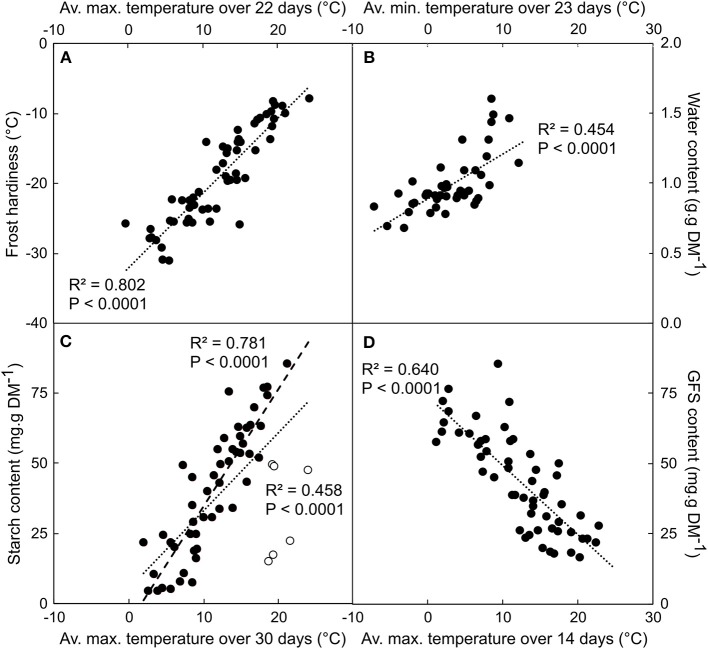
Correlation between frost hardiness (A), water (B), starch (C), and GFS (D) contents depending on average maximum (or minimal for water content) temperature calculated over 22 (FH), 14 (GFS), 30 (Starch), and 23 (WC) days period. Data were collected during six different winter dynamics from 2007 until 2012. Each point represents the mean of n = 5 replicates. Open circles in (C) represent data collected during the leafy period that were included or not in the linear regression (dotted and dashed line, respectively).